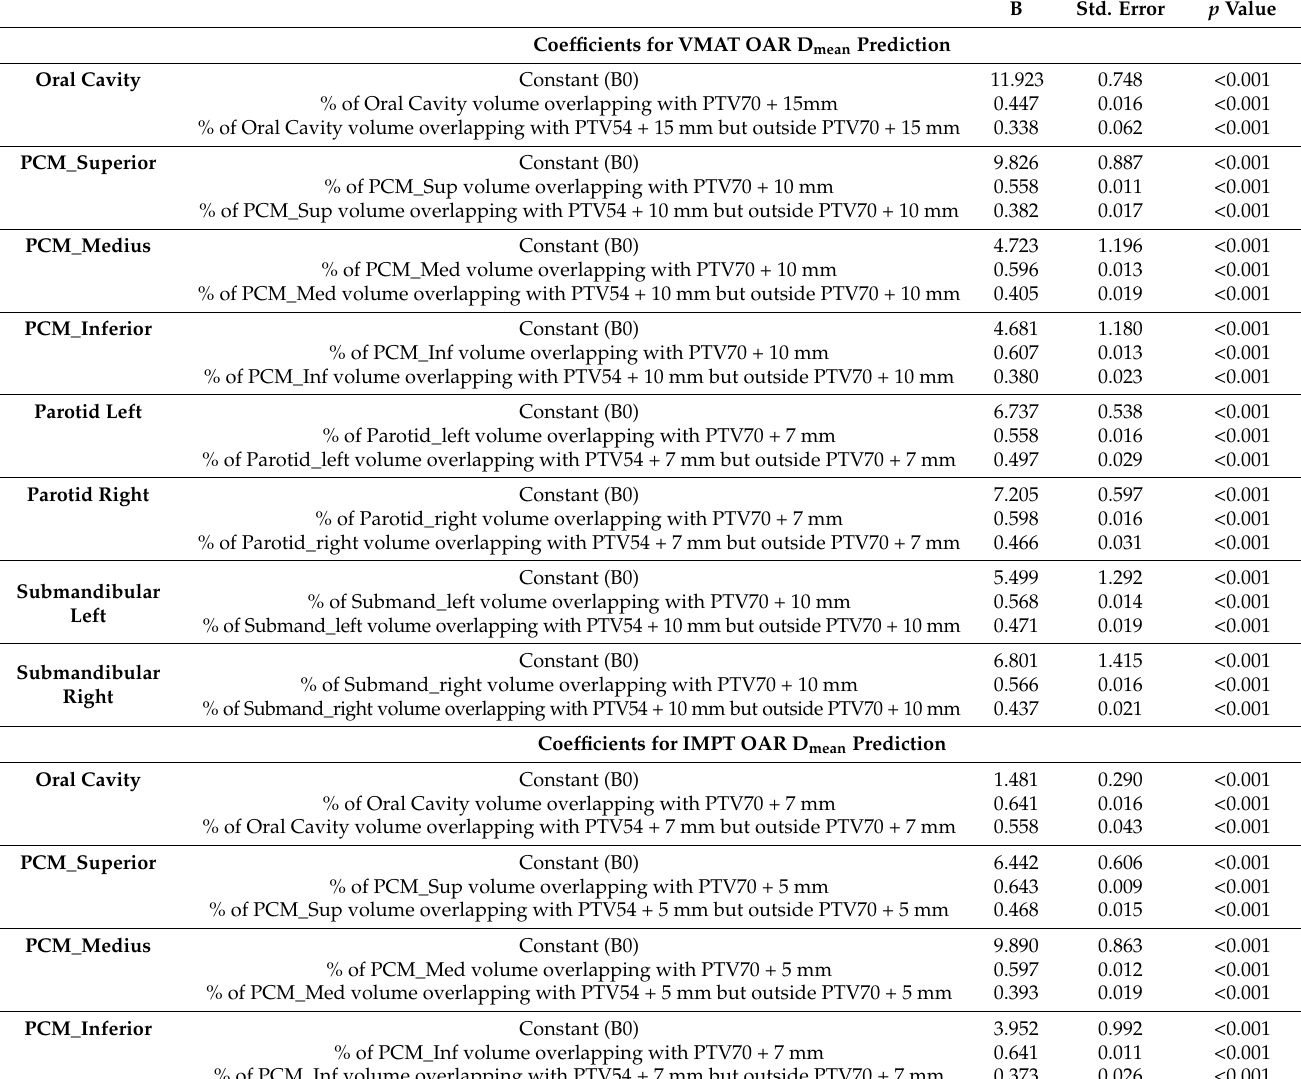
Table A4. The coefficients of the models for VMAT and IMPT D mean